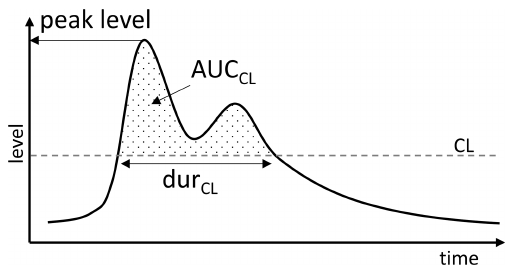
Figure 4. Simple representation of the